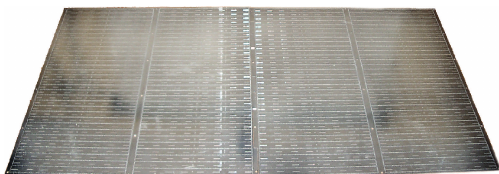
Figure 4: RX panel realized in SIW technology. The array is made of 32 × 32 slots, with a size of approximately 40 × 80 cm.